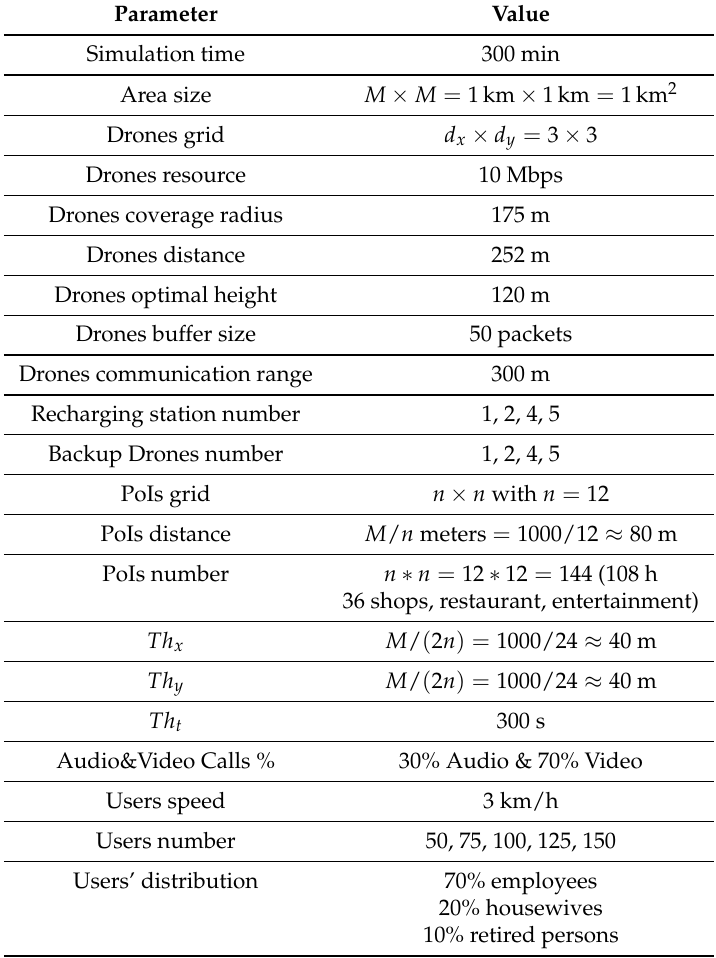
Table 5. Simulation